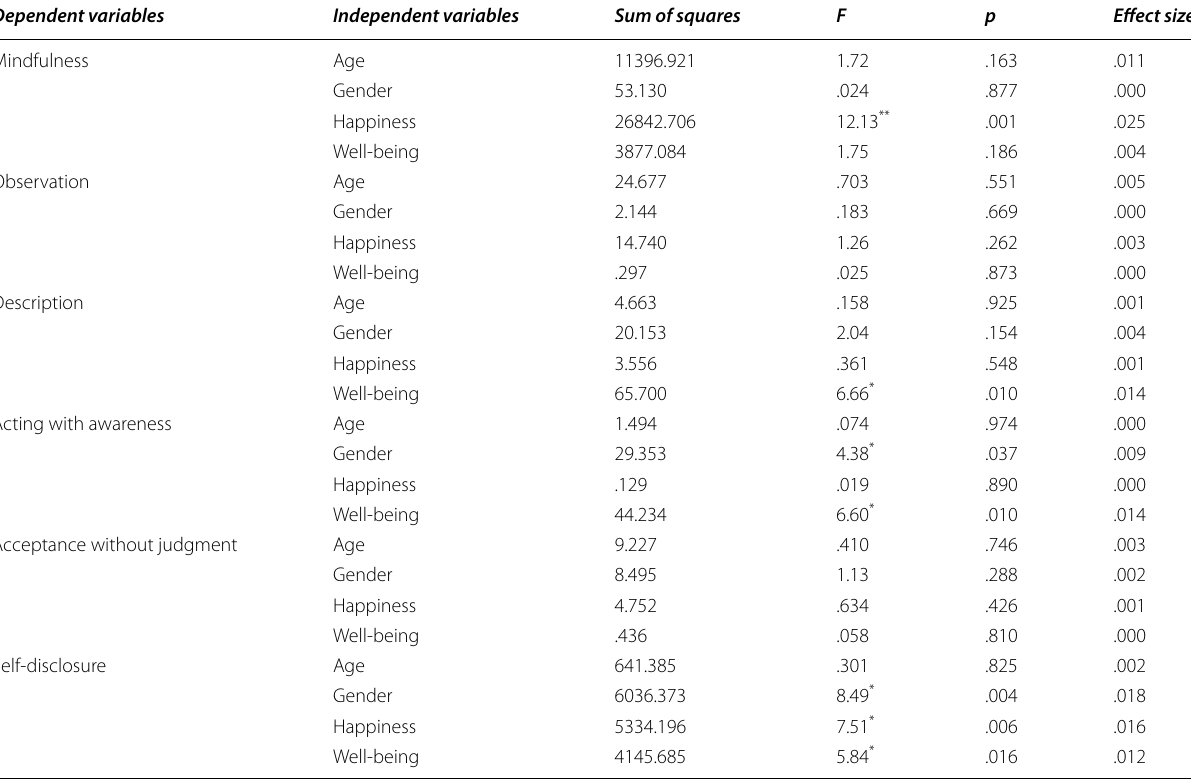
Table 4 Multiple-way analysis of variance between mindfulness and self-disclosure of happiness, well-being, gender, and age